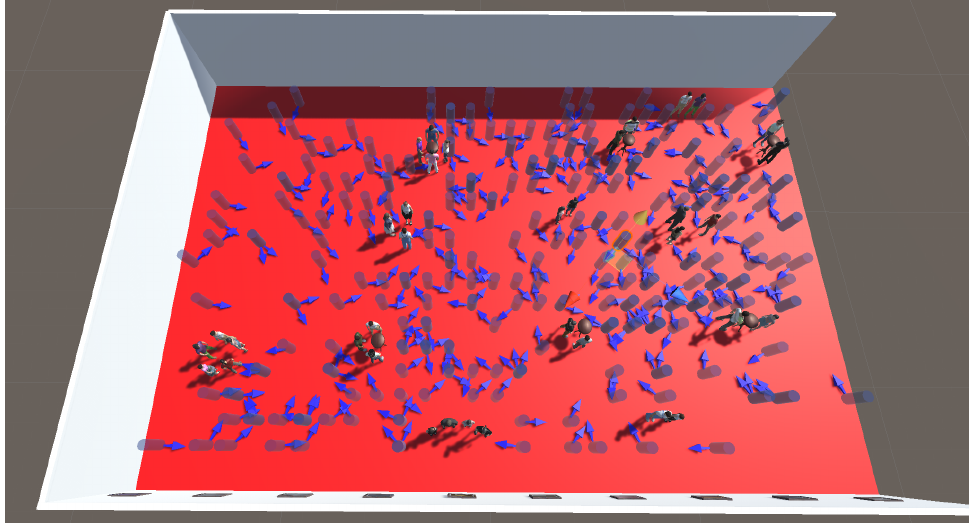
Figure 14. The global view of Scene 1, along with 247 positions for the robot (best viewed in